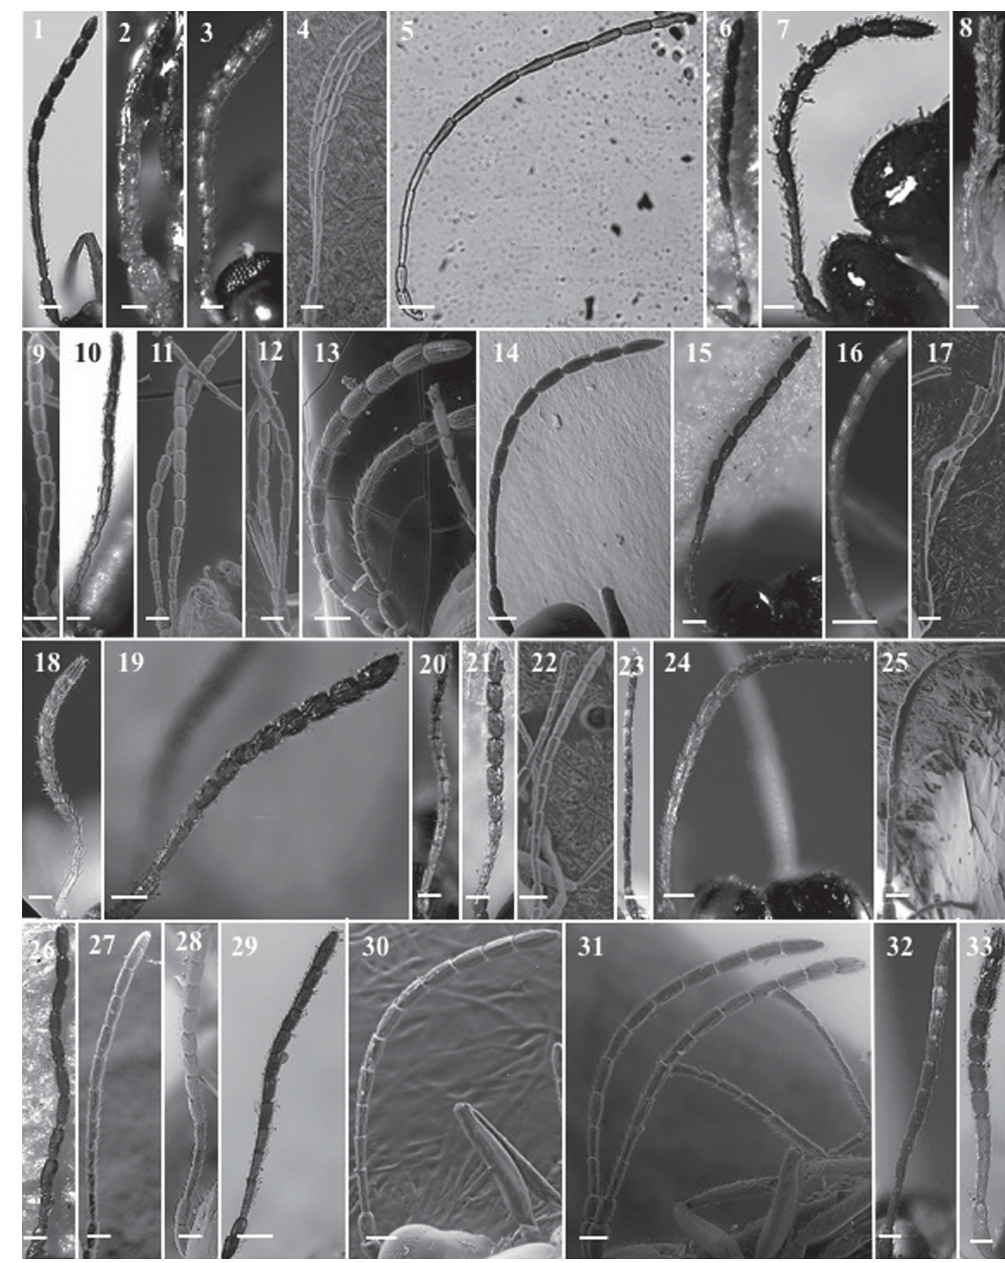
Fig. 2. Types of antenna of Alloxysta Förster, 1869. 1 . A. abdera Fergusson, 1986. 2 . A.